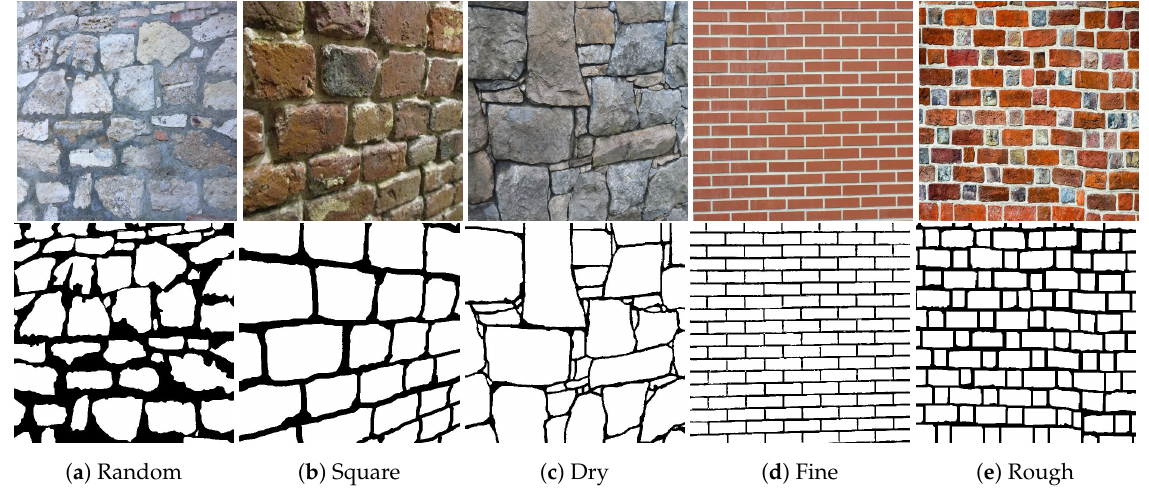
Figure 4. Sample base images from our dataset ( top row ), and the Ground Truth brick-mortar delineation maps (bottom row). Wall types: ( a ) Random rubble masonry, ( b ) Square rubble masonry, ( c ) Dry rubble masonry, ( d ) Ashlar fine, ( e ) Ashlar